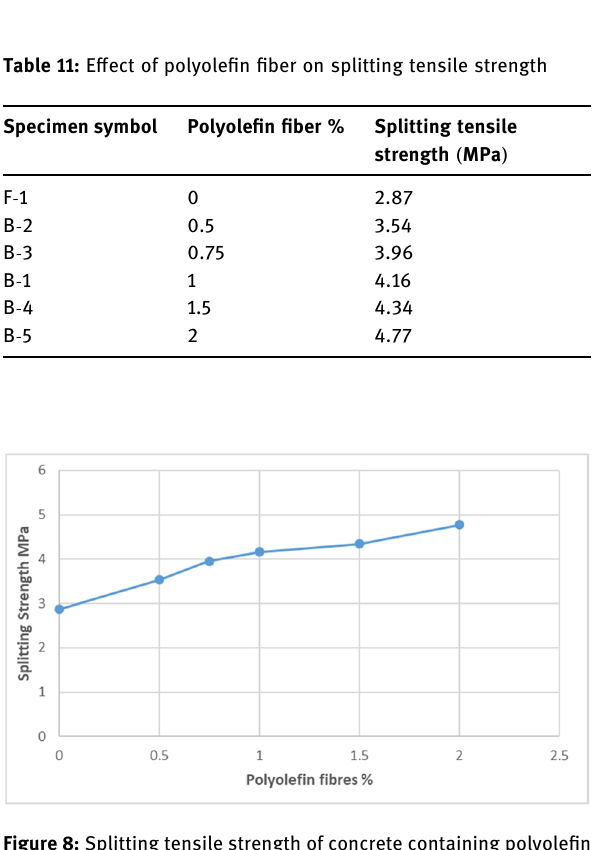
Figure 7: Flexural strength of concrete containing polyole fi n % in di ff erent mixes.